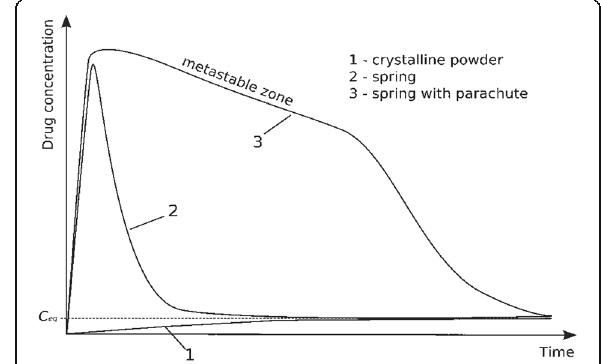
Fig. 12 Polymers can be used to generate a “ spring and parachute ” for amorphous solid dispersions (Adapted from Brouwers et al. 2009)